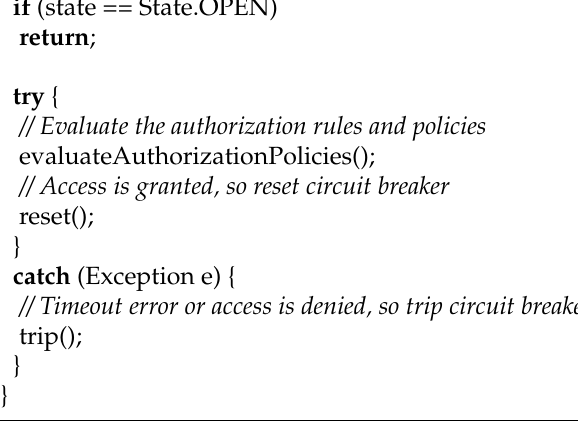
Figure 4. Java-based implementation of a circuit